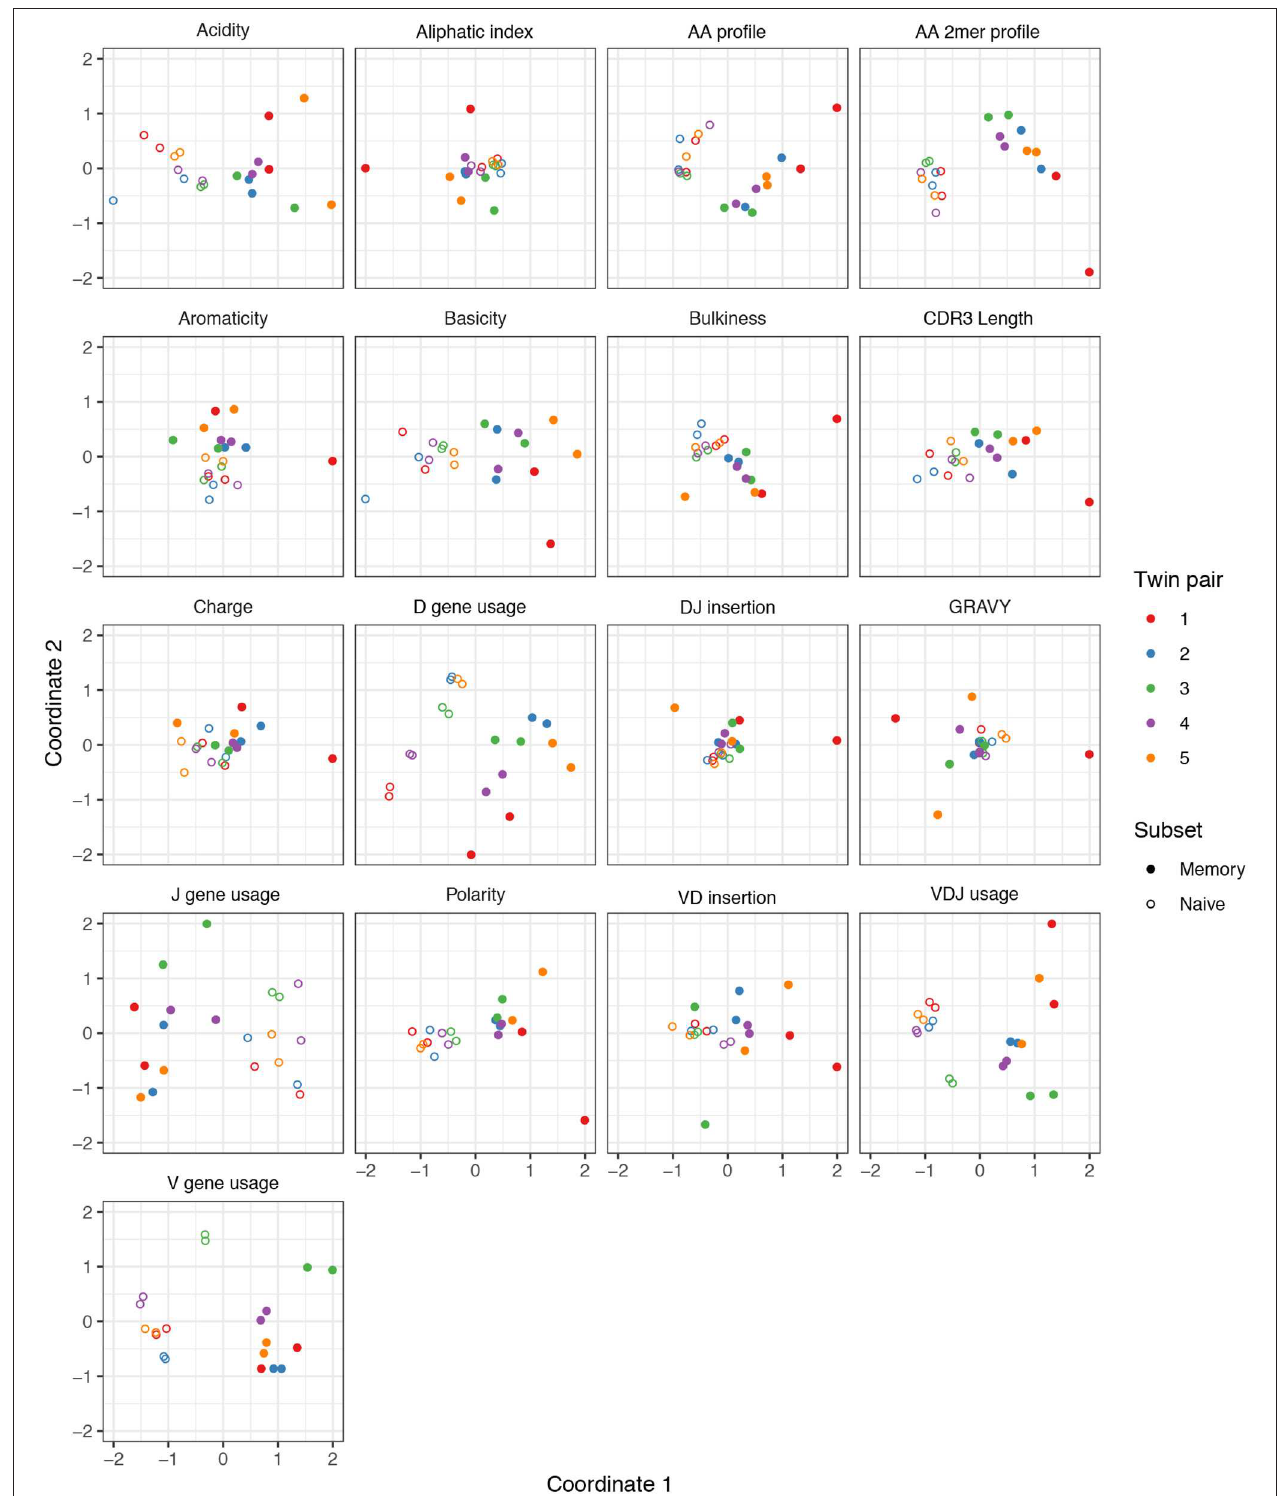
FIGURE 3 | Plots of summary divergence MDS coordinates for data from Rubelt et al. (33), grouped by twin pair identity and cell type (memory vs. naive).